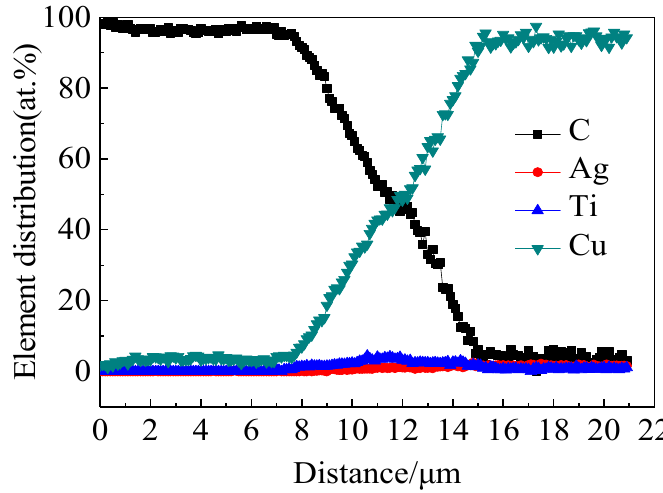
Figure 9. The interfacial structure of different Ti contents at the optimal parameters. ( a ) 6 wt.%, ( b ) 7.5 wt.%. Table 3. EDS results of marked points in Figure 9 (at.%).